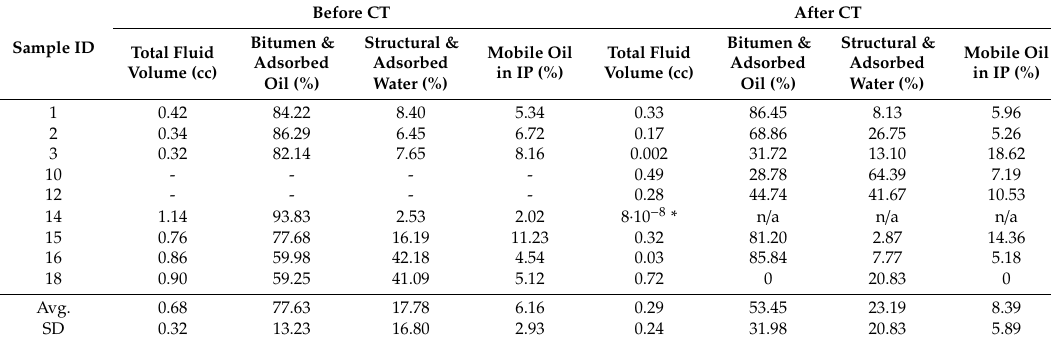
Table 7. Results of NMR T 1 –T 2 interpretation for target samples before and after CT.